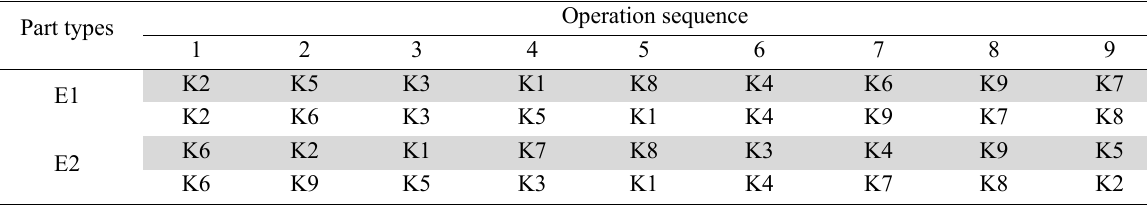
Part–machine centre incidence matrix